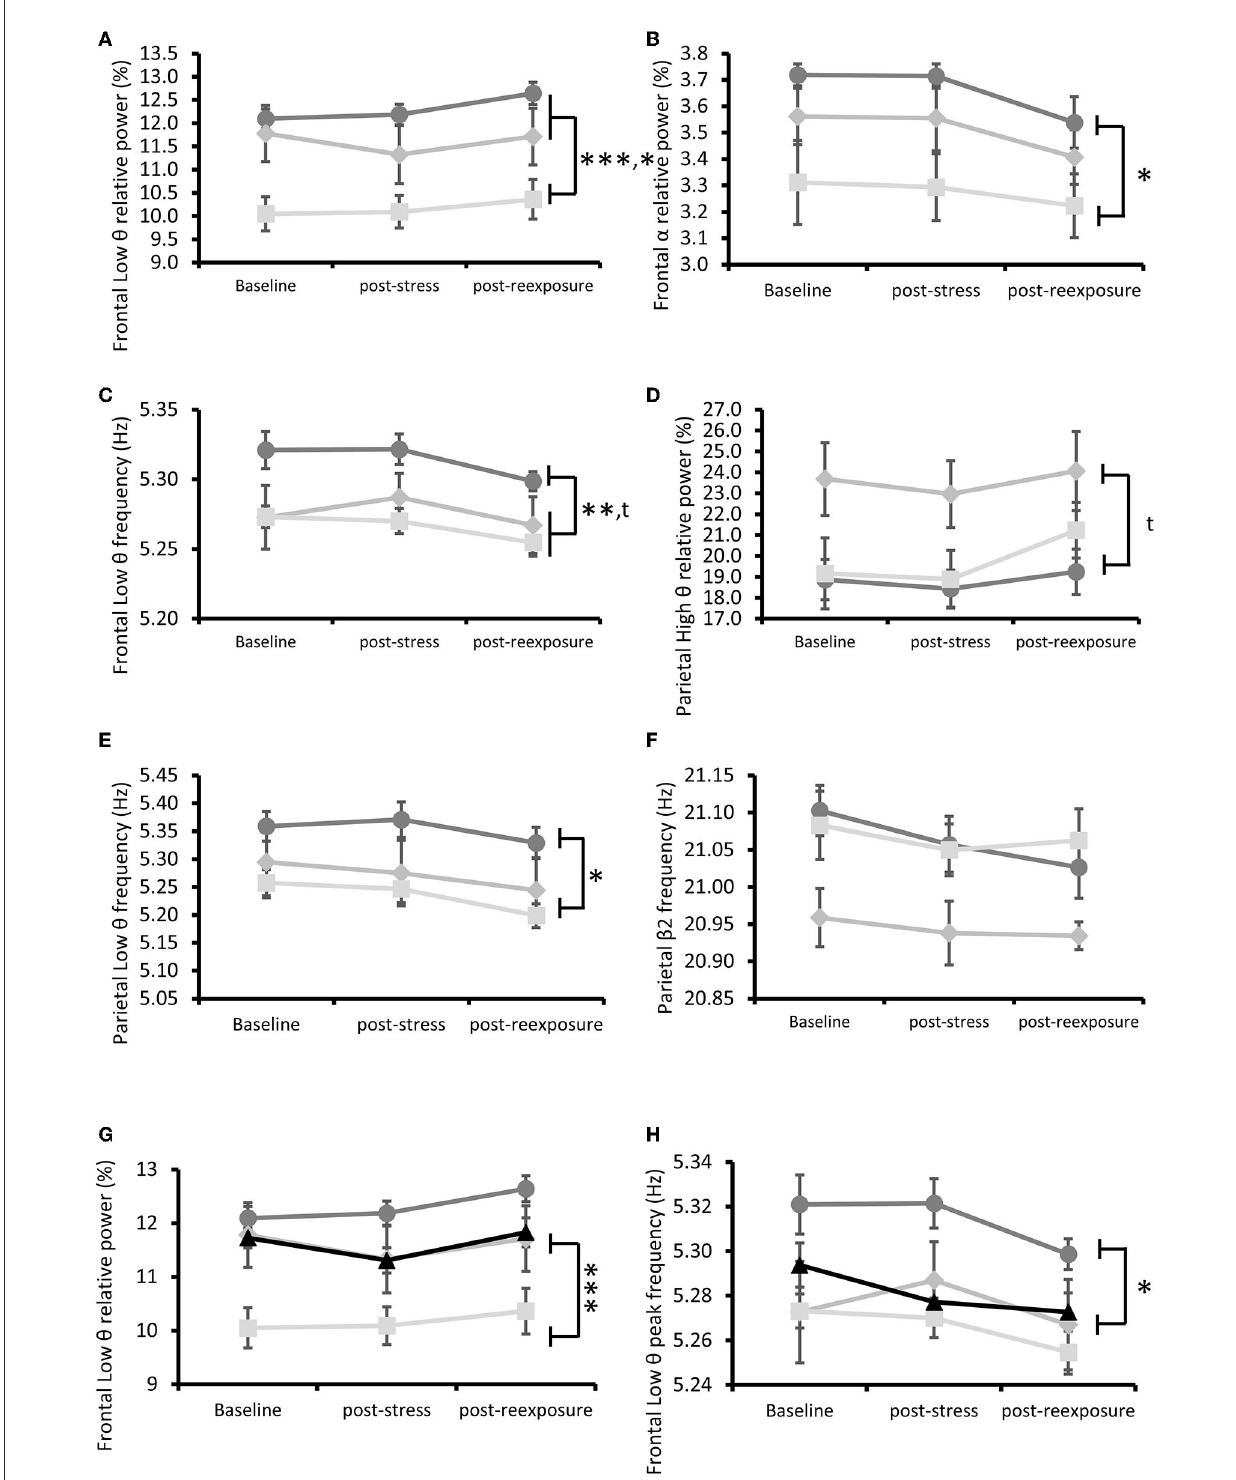
FIGURE7 ECoG subgroup characterization throughout the experiment. (A) Frontal Low θ relative power. * p < 0.05 between the C3 (Neotic) and C2 (Avoidance) subgroups, *** p < 0.001 between the C1 and C3 subgroups. (B) Frontal α relative power. * p < 0.05 between the C1 and C3 subgroups. (C) Frontal Low θ frequency. ** p < 0.01 between the C1 and C3 subgroups, t p < 0.10 between the C1 and C2 subgroups. (D) Parietal High θ relative power. t p < 0.10 between the C1 and C2 subgroups. (E) Parietal Low θ frequency. * p < 0.05 between the C1 and C3 subgroups. (F) Parietal β 2 frequency. (G) Frontal Low θ relative power. Stress subgroups compared to the Sham group. Post-hoc test *** p < 0.001 between the C3 subgroup and the Sham group. (H) Frontal Low θ frequency. Post-hoc test * p < 0.05 between the C1 subgroup and the Sham group. Results are expressed as mean ±